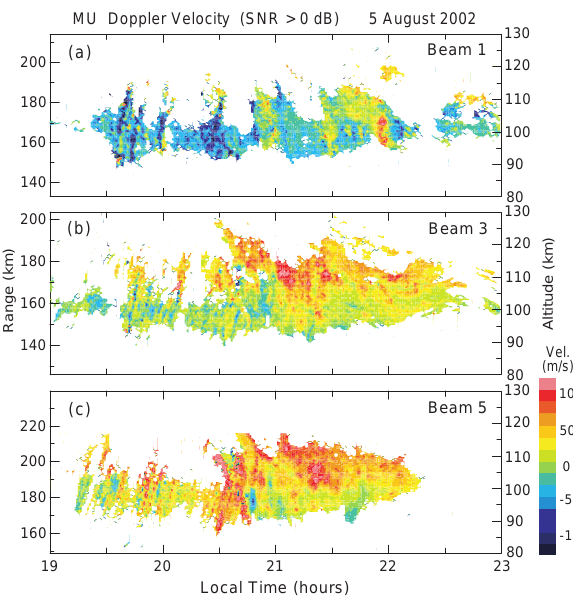
Fig. 6. Range-time-Doppler velocity plots of MU radar echoes with SNRs higher than 0 dB on beams 1, 3 and 5. Plus (minus) sign of Doppler velocity represents motion away from (toward) the radar.